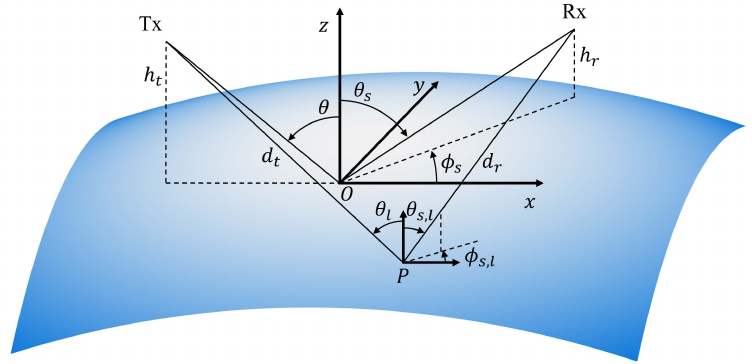
Figure 2. Scattering geometry and reference system. Table 1. List of symbols and corresponding definition and value.